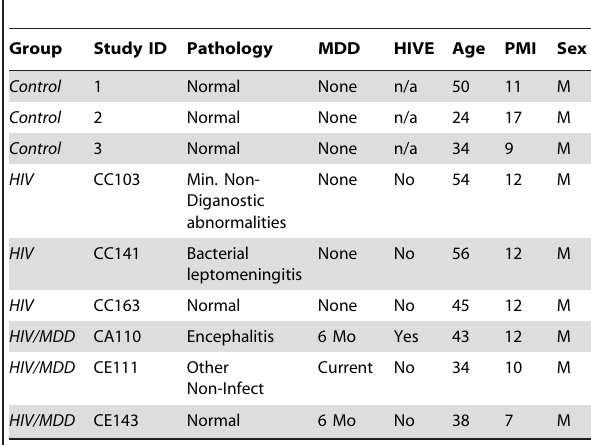
Table 1. Characteristics of Cases in miRNA